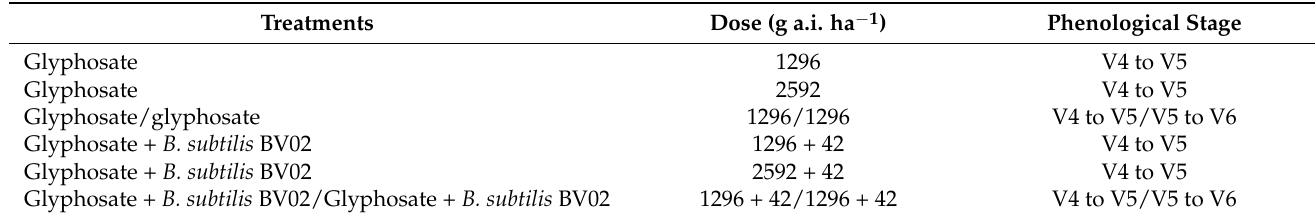
Table 1. Treatments and respective doses used in the experiment carried out with soybean submitted to post-emergence application of glyphosate at different doses and stages and associated with B. subtilis